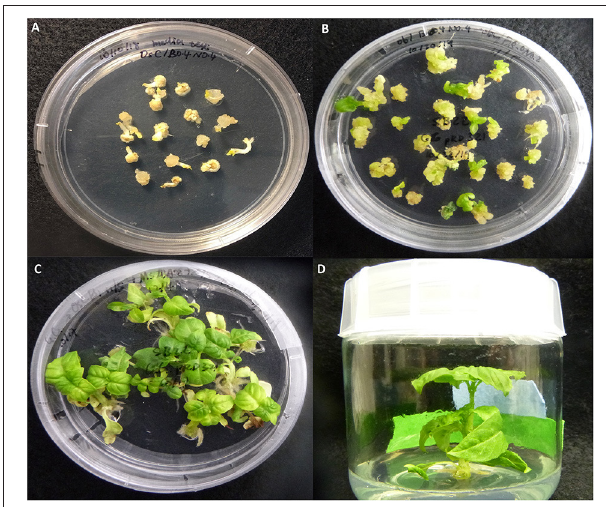
FIGURE 2 | Transformation and regeneration of SB22 following biolistic bombardment with the transient CRISPR-editing vector pRD321. (A) Callus induced from bombarded embryos, (B) Shoot induction from calli, (C) Shoot culturing and elongation, and (D) Root